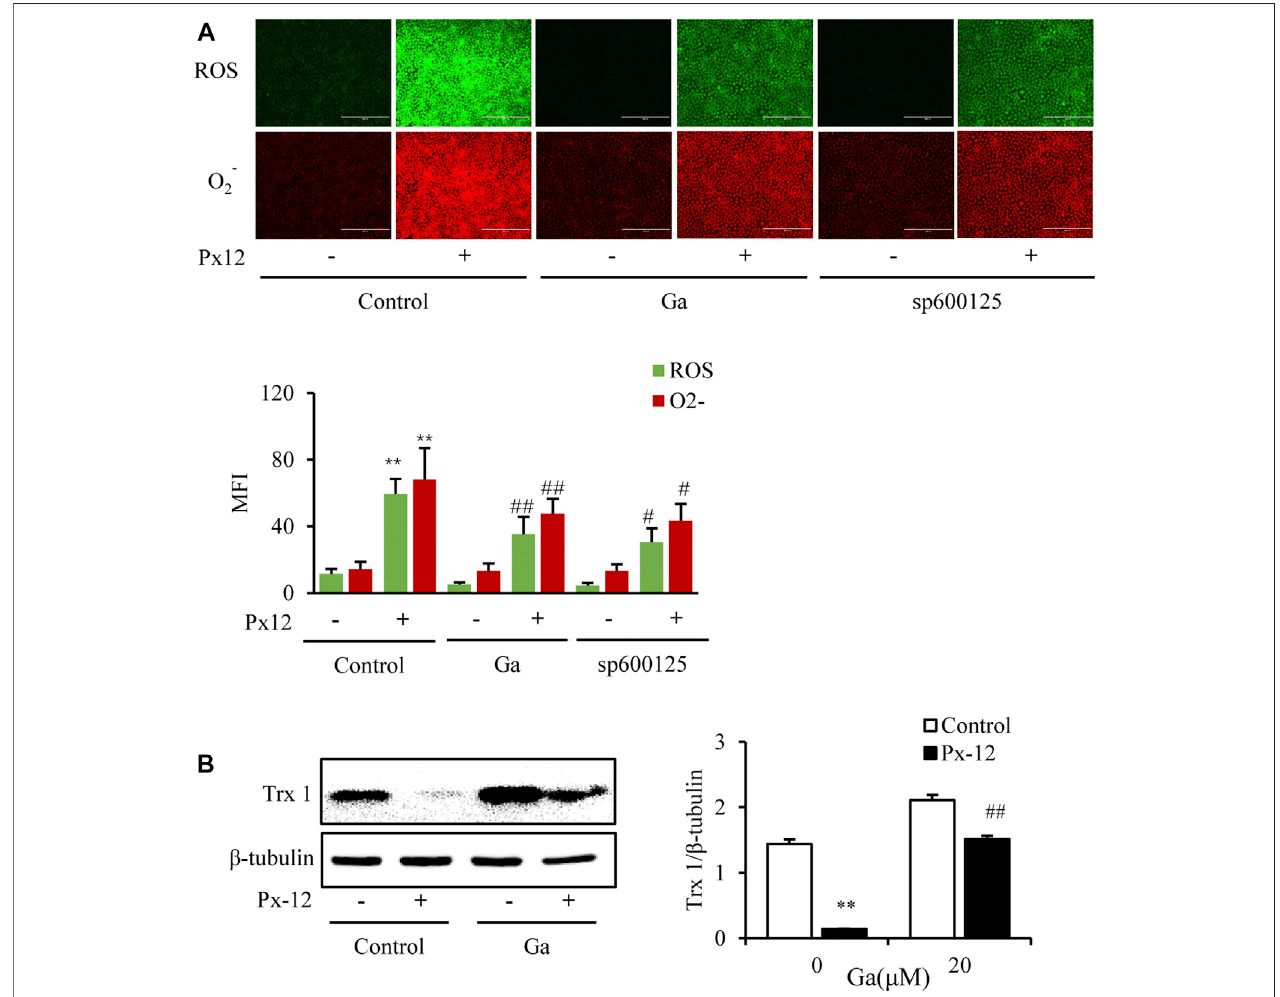
FIGURE 5 | Connexin 43 (Cx43) inhibition suppresses oxidative stress by regulating thioredoxin 1. (A) Effect of 18 α -glycyrrhetinic acid (Ga) and sp600125 on reactive oxygens species (ROS)/O 2 − production. NRK-52E cells in a 96-well plate were pretreated with Ga and sp600125 separately for 1 h, challenged with Px-12 for another 1 h, and then incubated with a ROS/O 2 − probe for 30 min. Images were captured using an inverted fl uorescence microscope ( × 100). Mean fl uorescence intensityisshownatthebottom(mean ± SD, n (cid:2) 3;** p < 0.01vs.thecontrol,## p < 0.01vs.Px-12inthecontrol). (B) EffectsofGaonthioredoxin1.NRK-52E cells in six-well plates were pretreated with Ga for 1 h and then challenged with Px-12 for another 1 h. Then, cellular lysates were analyzed by western blotting for the expression of thioredoxin 1. Densitometric analysis of thioredoxin 1, as determined by ImageJ, is shown on the right (mean ± SD, n (cid:2) 3; ** p < 0.01 vs. the control, ## p < 0.01 vs. Px-12 in the siRNA control group).